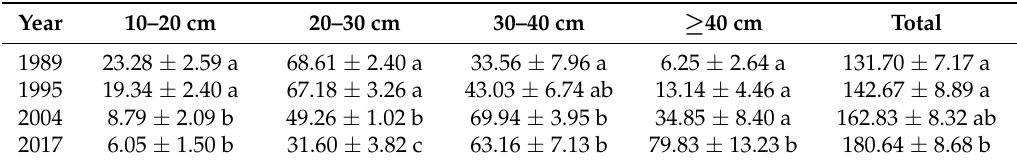
Table 5. Change of aboveground biomass of each DBH class of all trees in the permanent plot (10–20 cm means 10 cm ≤ DBH < 20 cm) a